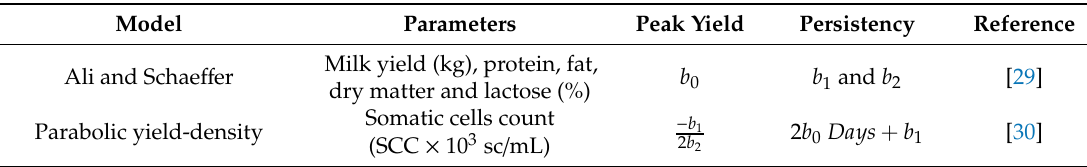
Table 1. Peak yield and persistence estimates for the lactation curve model for milk yield and composition. Model Parameters Peak Yield Persistency Reference Milk yield (kg), protein, fat, Ali and Schae ff er dry matter and lactose (%) Parabolic